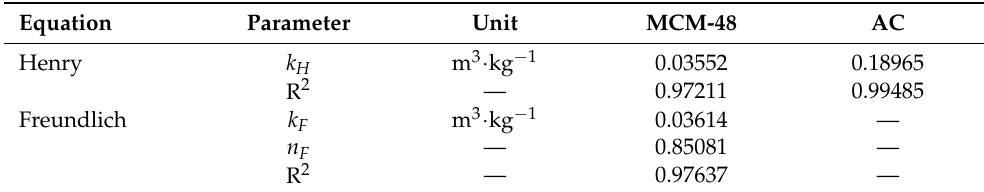
Figure A14. Uptake of RuCp 2 at 14 MPa and 333 K on different substrates; experimental data taken from [64]. Table A14. Adsorption isotherm parameters for RuCp 2 from scCO 2 solution at 14 MPa and 333 K on different substrates [64].